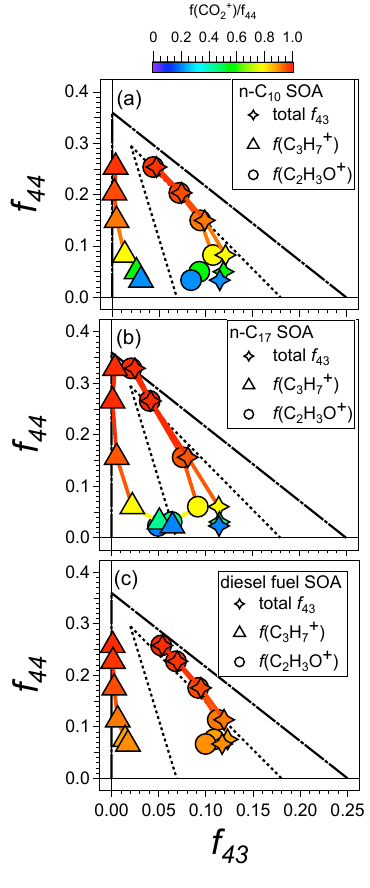
Fig. 3. f 44 shown as a function of f low), and total f 43 (red) for SOA generated in the PAM reactor from the oxidation of (a) n -C 10 , (b) n -C 17 , and (c) diesel fuel. Dashed lines indicate range of ambient f 44 and f 43 measurements, while dashed-and-dotted lines indicate range of laboratory PAM reactor measurements.